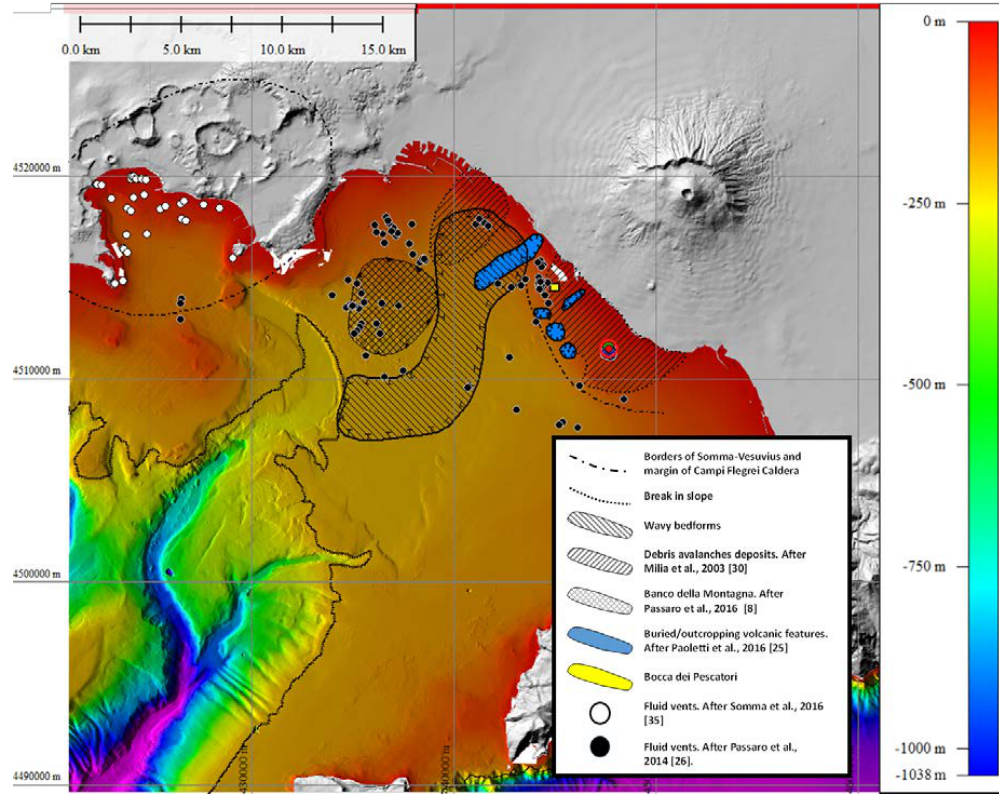
Figure 6. Map of the main seafloor morphologies of the Somma-Vesuvius offshore.